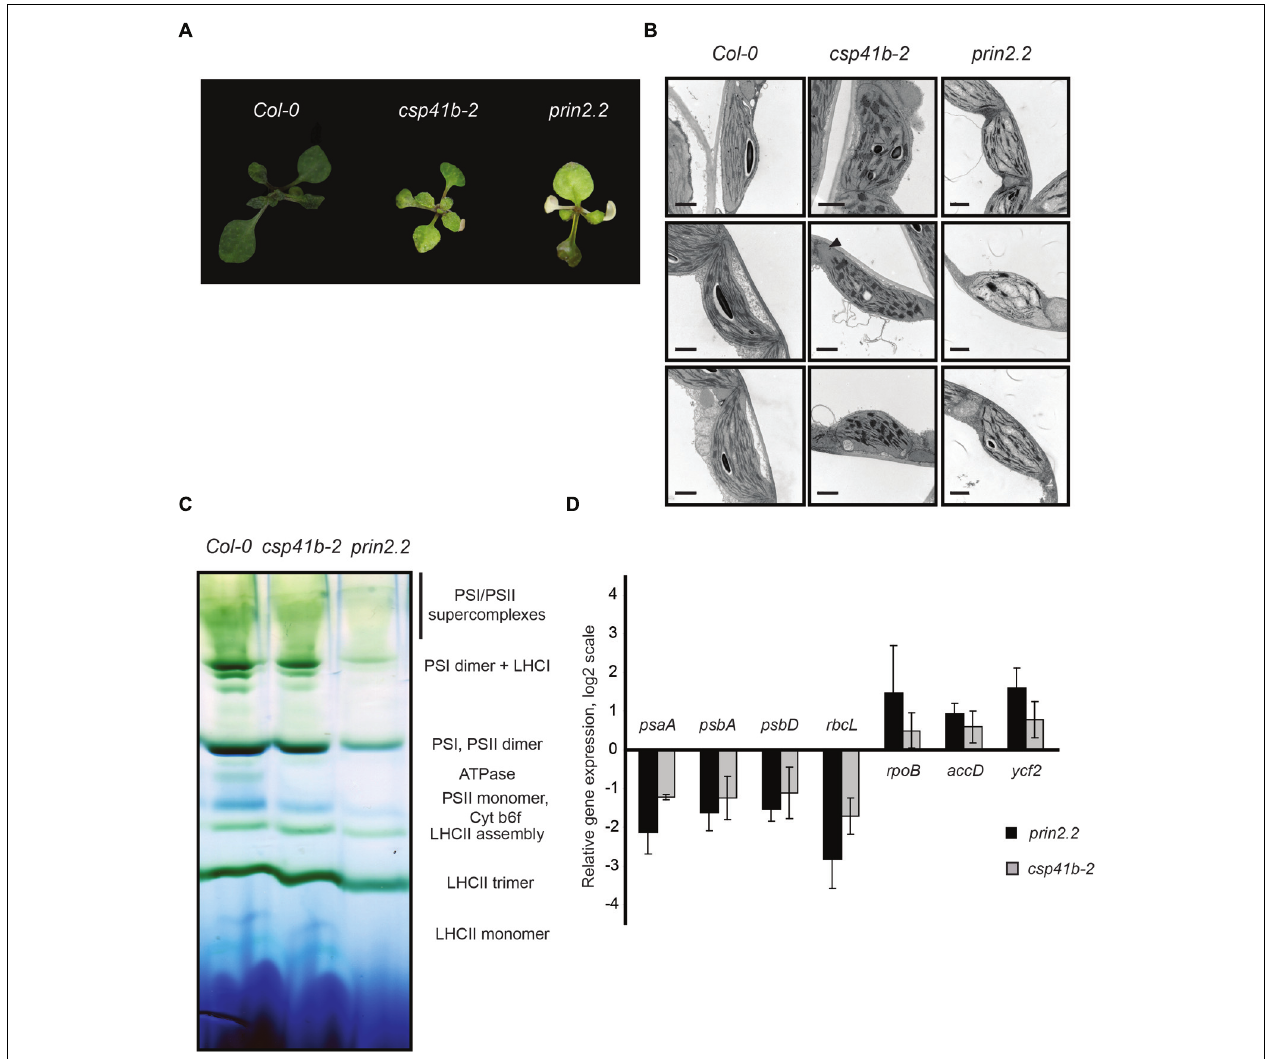
FIGURE 2 |The prin2 and csp41b-2 show severe plant phenotypes. Plants were grown on soil under long day conditions (16 h light/8 h darkness) to characterize prin2.2 and csp41b-2 mutants (A) Representative images of plants grown on soil for 3 weeks. (B) RepresentativeTEM images of chloroplasts from the Col-0, csp41b-2, and prin2.2 rosette plants. Bars represent 1 μ m (C) Blue Native PAGE of thylakoid membrane complexes